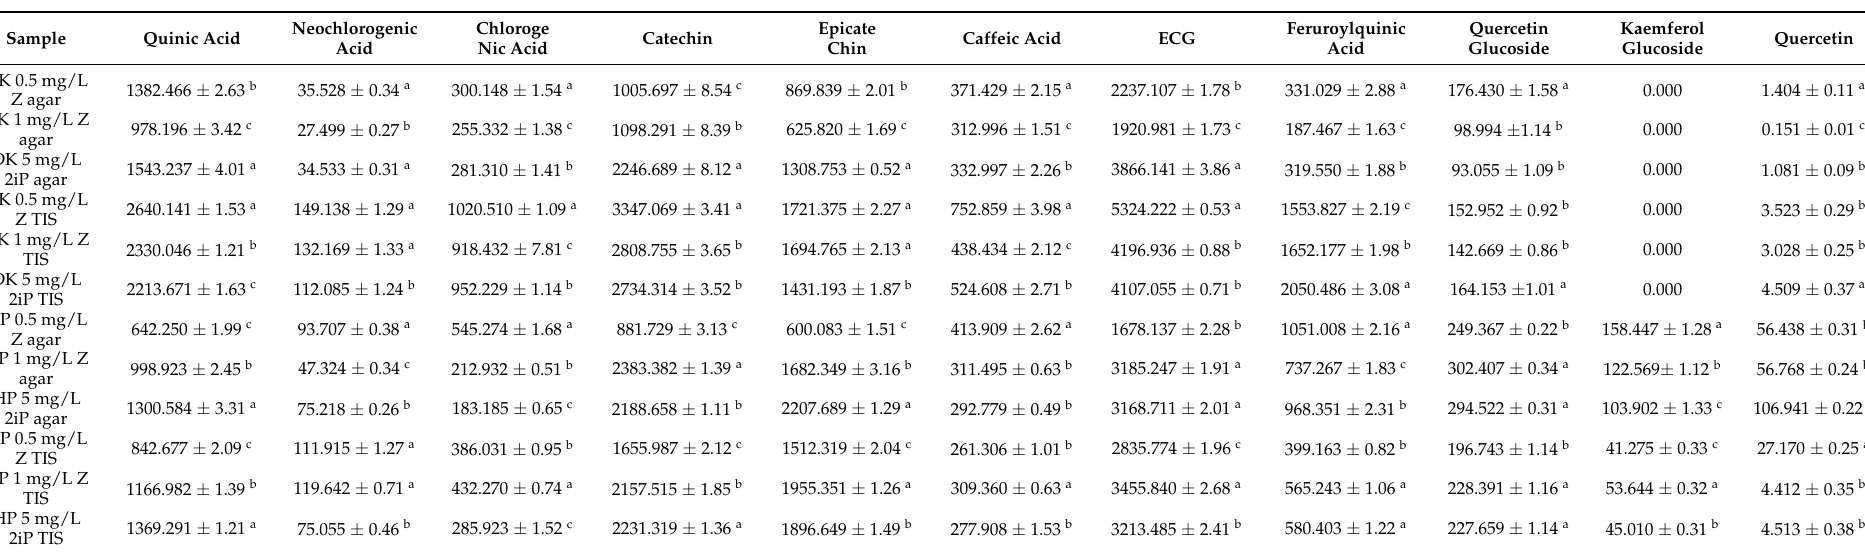
Table 1. The content of individual phenolic compounds in the shoot extracts of the two highbush blueberry ( V. corymbosum ) varieties cultivated in vitro, using HPLC-MS and expressed as µ g/g